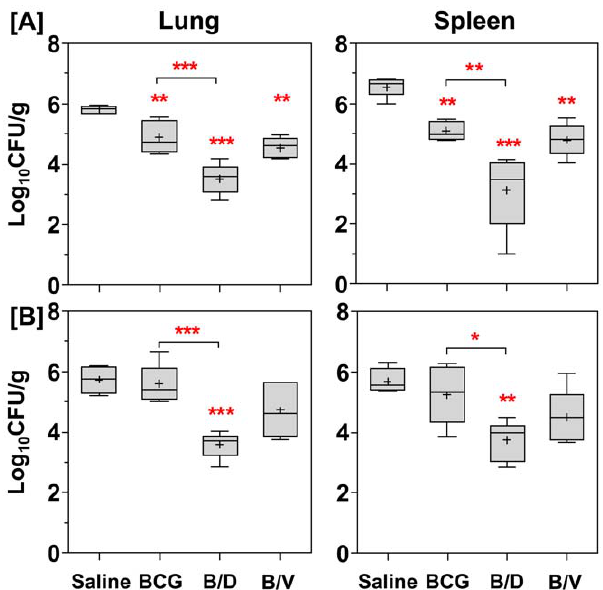
Figure 1. Enhanced protection against M.tuberculosis challenge by DNAacr boosting subsequent to BCG vaccination. For evaluation of protective efficacy two guinea pig experiments were performed. The figure depicts the bacillary load in the lungs and spleen of vaccinated and saline treated guinea pigs at (A) 10 weeks (Exp-I, n=5) and (B) 16 weeks (Exp-II, n=6) post-infection. Immunization with B/D regimen resulted in a significantly lower bacillary load in lungs and spleen, when compared to both BCG and saline groups. Log 10 CFU were measured and graphically represented by box plot, wherein median values are denoted by horizontal line, the mean is represented by ‘ + ’, inter quartile range by boxes, and the maximum and minimum values by whiskers. The lower limit of detection was 1.0 log 10 CFU/g of tissue and animals with undetectable bacilli were allotted a CFU value of 1.0 log 10 /g. B/D, BCG prime – DNAacr boost and B/V, BCG prime – vector boost. *, p , 0.05, **, p , 0.01, ***, p , 0.001, when compared to the saline group or as indicated (One-way